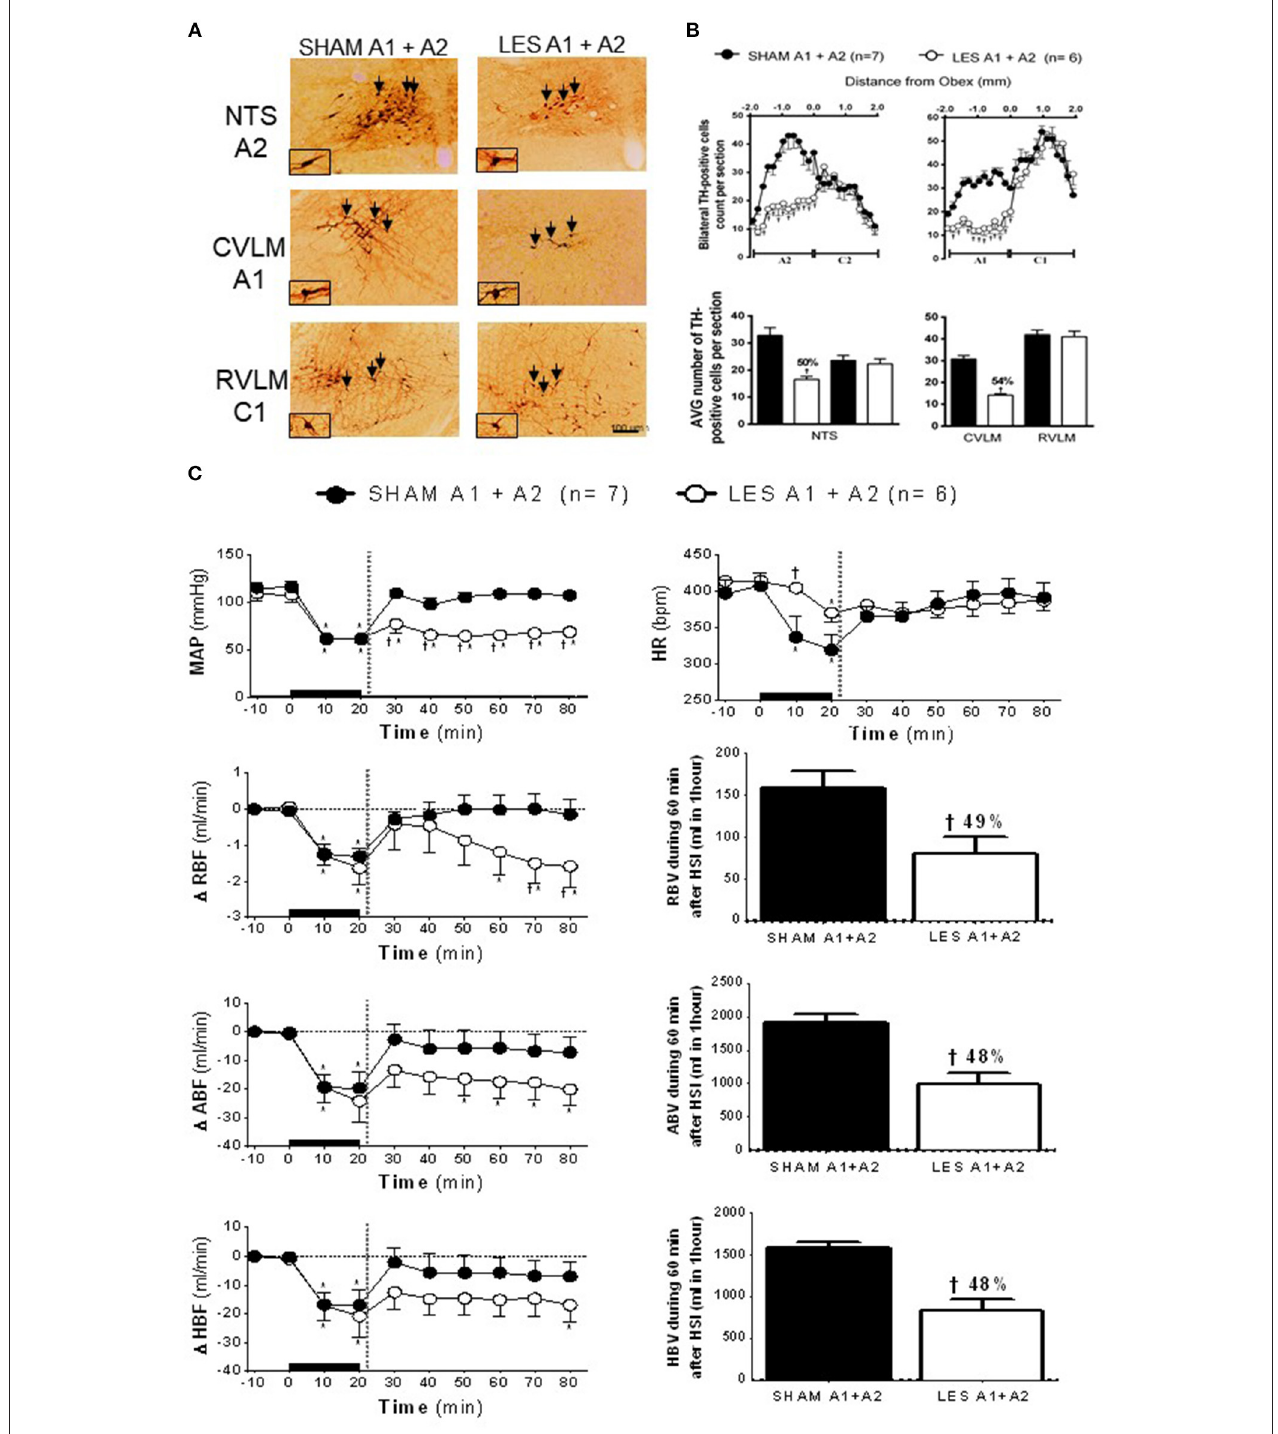
FIGURE 3 | (A) A representative photomicrograph of medullary coronal sections (40 µ m) with the scale bar of 100 µ m. The arrows indicate positive tyrosine hydroxylase neurons in the nucleus of the solitary tract (NTS—cluster A2), caudal ventrolateral medulla (CVLM—cluster A1), and rostrovetrolateral medulla region (RVLM—cluster C1) of the animals bilaterally nanoinjected with saporin (SHAM A1 + A2) or saporin-anti-D β H (LES A1 + A2) in CVLM and NTS. (B) Quantification of tyrosine hydroxylase (TH)-positive cells in the medullary regions. The number of positive TH cells in the nucleus of the solitary tract (NTS—clusters A2 and C2), caudal ventrolateral medulla (CVLM—cluster A1), and rostrovetrolateral medulla region (RVLM—cluster C1) of the animals receiving nanoinjection of bilateral saporin